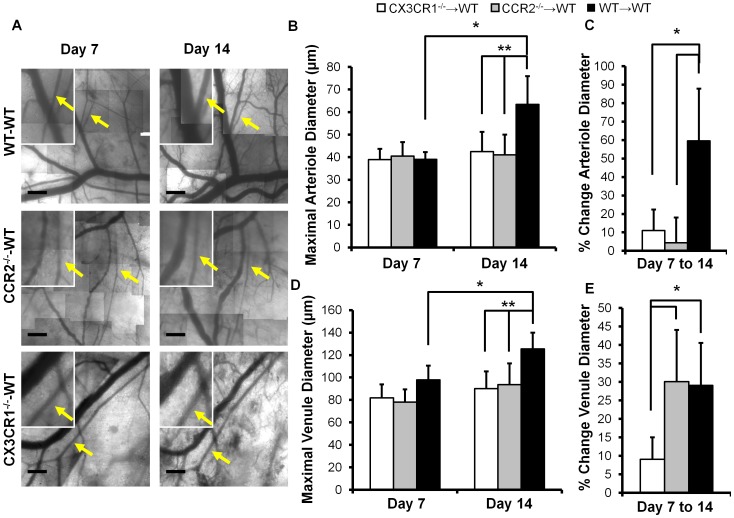
Arteriolar and venule remodeling in dorsal skinfold window chamber is differentially altered by bone marrow specific loss of CCR2 and CX3CR1.A) Representative images of window chamber regions at day 7 and 14 from experimental groups. Insets are higher magnification images of selected regions (arrows indicate arterioles, scale bar is 300 µm). Mean arteriole (B) and venule (D) diameters were quantified in all microvascular segments for each mouse in experimental groups at day 7 and 14 (*, indicates significant difference between days within a group, and ** between groups within a day, p<0.05). Average percent change in diameter from day 7 to 14 was quantified in all arteriole (C) or venule (E) segments per mouse and averaged across experimental groups (*, indicates p<0.05 significant difference between groups). [Data represents n = 7 WT→WT, n = 4 CX3CR1−/−→WT, and n = 6 CCR2−/−→WT mice per group].